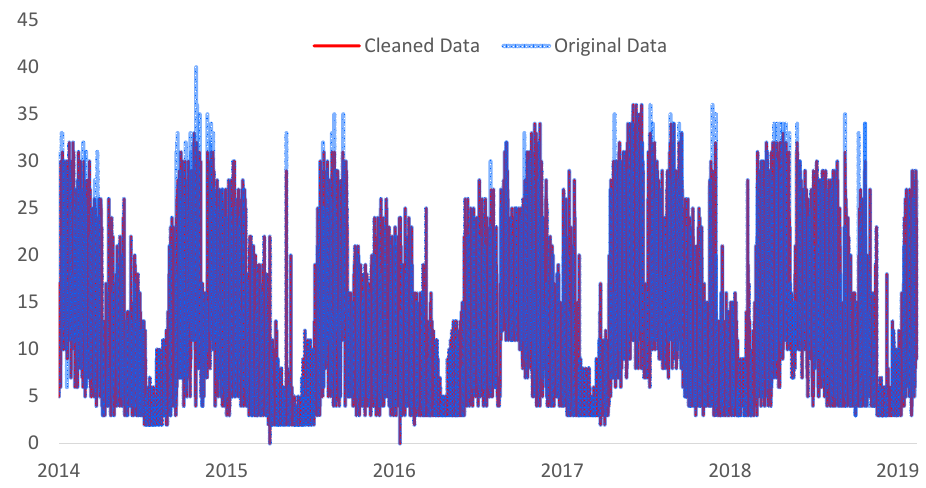
Figure 7. Original and cleaned data for the Faculty of Building Services location. Table 4. Number of valid/invalid outliers detected using the implemented scoring method for Faculty of Building Services location.